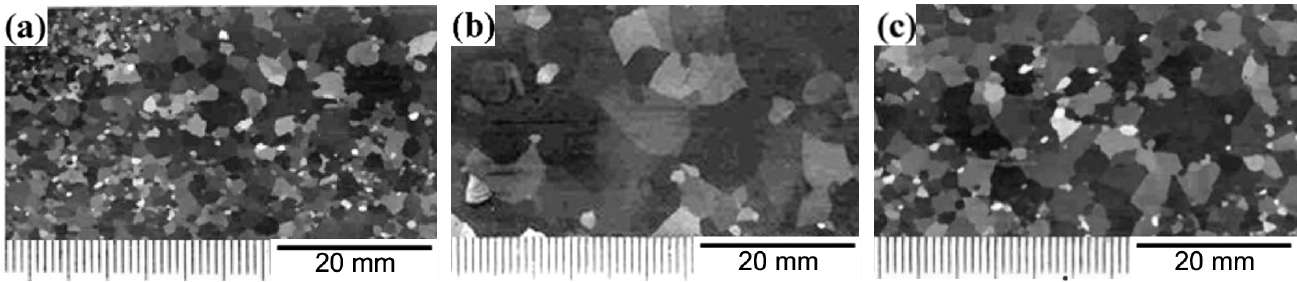
Figure 2. Macrostructure of finally annealed samples in different atmospheres: ( a ) 100%H 2 ; ( b ) 25%H 2 + 75%N 2 ; ( c ) 50%N 2 + 50%H 2 .